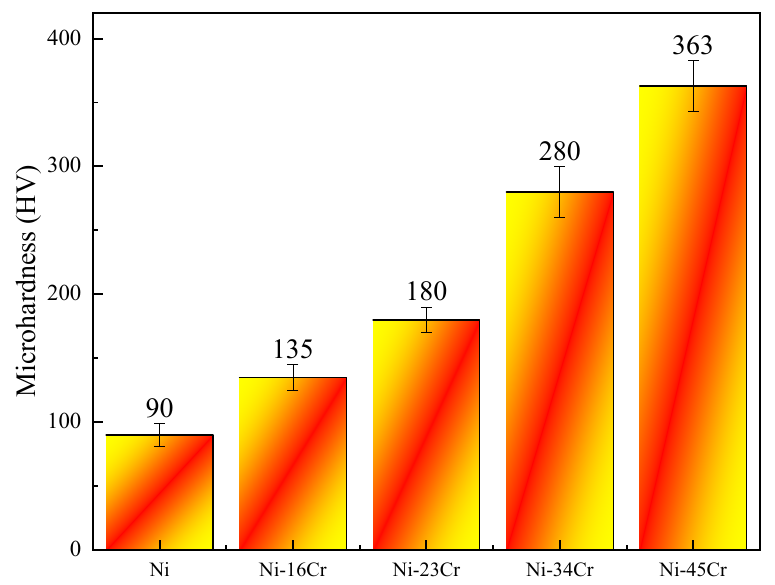
Figure 6. Microhardness of Ni and NiCr alloys.